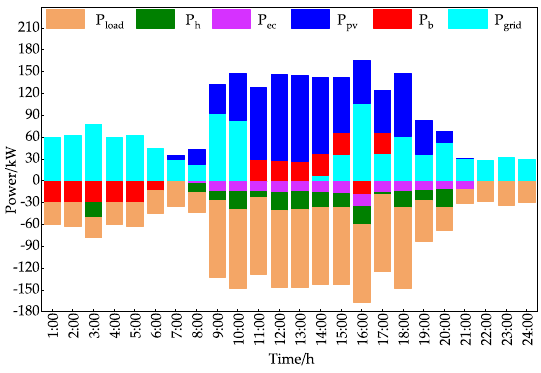
Figure 6. The optimal scheduling results when only electric water heater-based VES (EWHVES) is